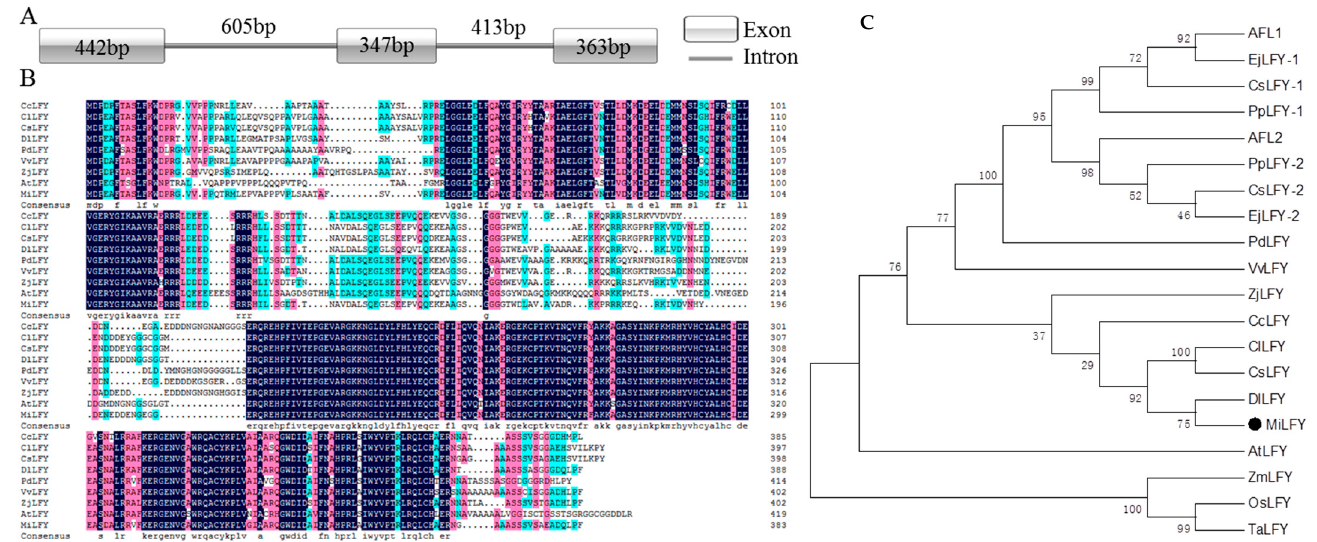
Figure 1. Sequence analysis of LFY genes. ( A ) Gene structure of MiLFY genes. ( B ) Amino acid sequence alignment of LFY proteins from different species. ( C ) Phylogenetic tree of LFY proteins from various species. The species, gene names, and GenBank accession numbers are as follows: Citrus sinensis (CsLFY, AY338976.1), Carya cathayensis (CcLFY, DQ989225.1), Pyrus pyrifolia (PpLFY-1, AB162029.1), Pyrus pyrifolia (PpLFY-2, AB162035.1), Ziziphus jujuba (ZjLFY, JN165097.2), Dimocarpus longan